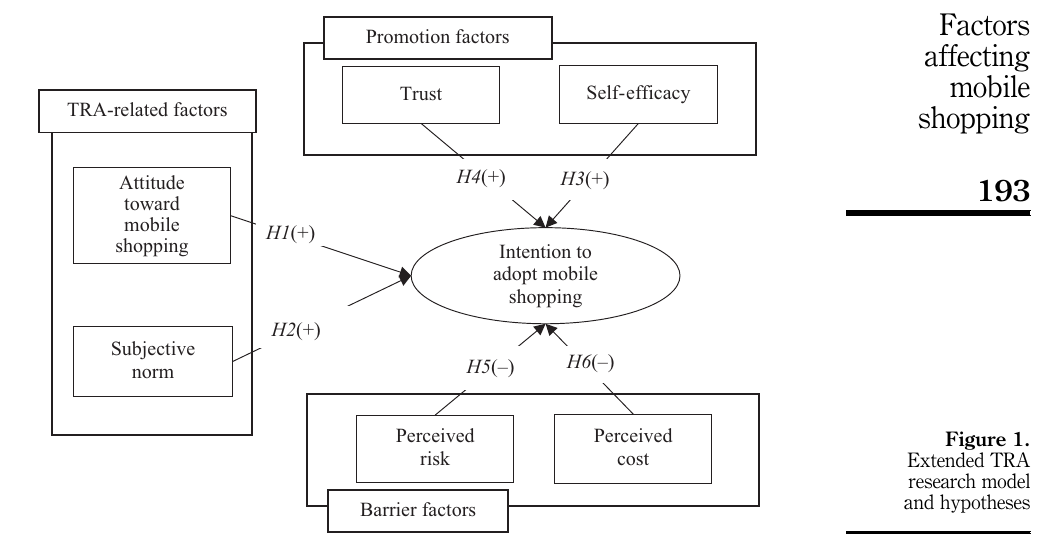
Figure 1. Extended TRA research model and